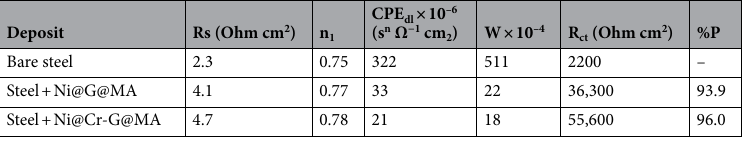
Table 3. The EIS parameters for the bare and SHP coated steel in 0.5 M NaCl solution.